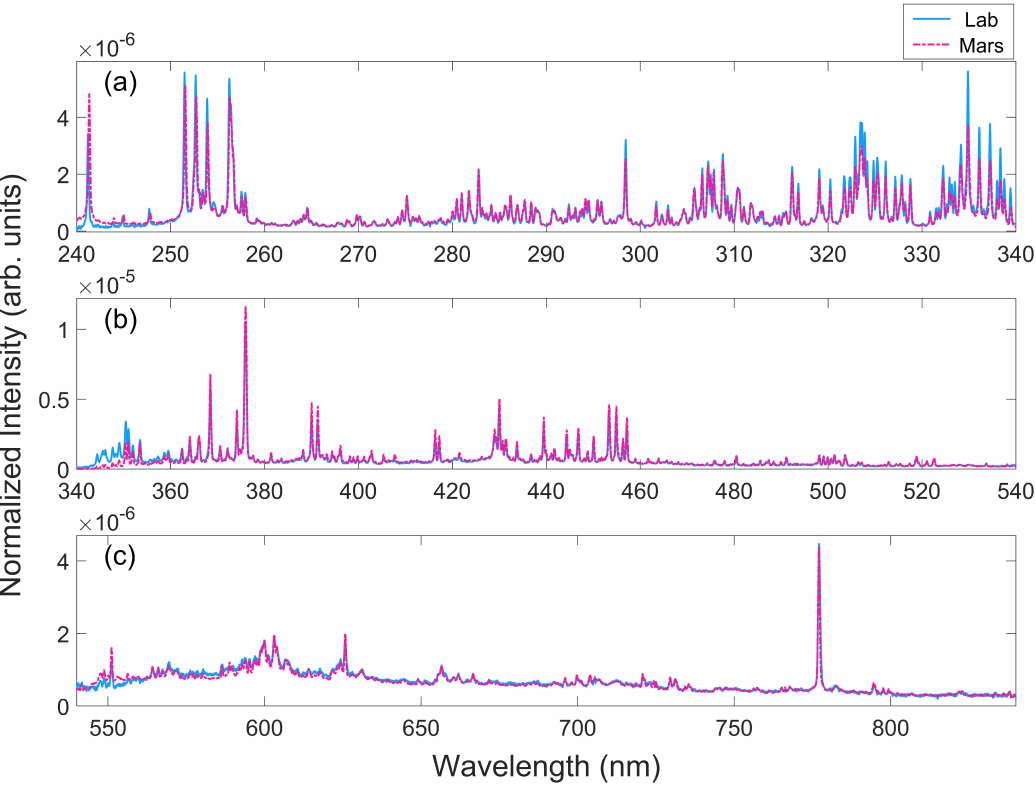
Figure 12. The LIBS spectra collected by MarSCoDe in field detection (calibration) on Mars (purple dashed lines) and by the MarSCoDe laboratory model in the simulated Martian environment (blue lines), with the targets being two identical Ti alloy samples. ( a ) The spectra in Channel 1. ( b ) The spectra in Channel 2. ( c ) The spectra in Channel